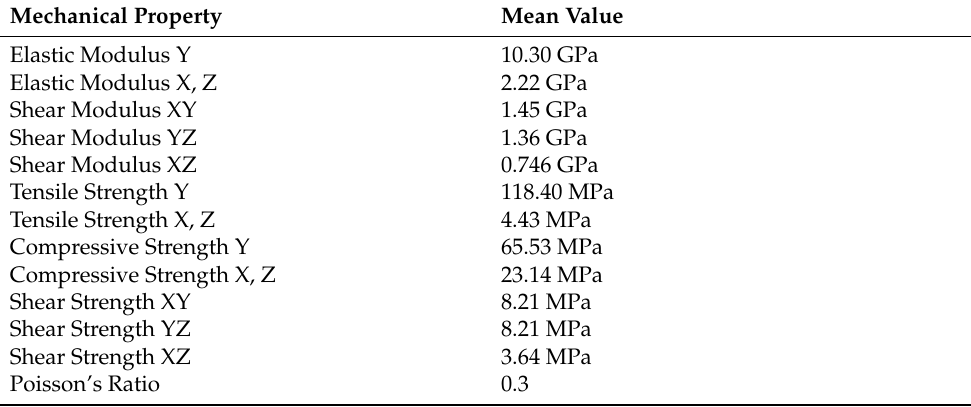
Table 1. Materials used for the preparation of the